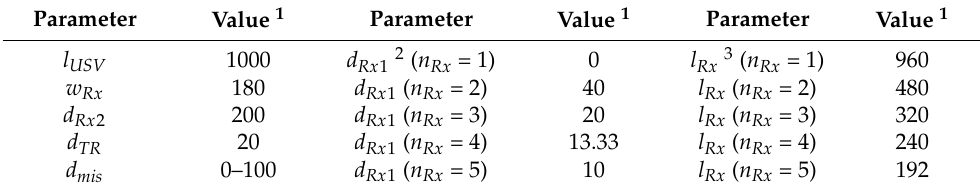
1 Unit: mm. 2 For Tx coils with the same number of coil units as Rx coils, corresponding d Tx 1 are the